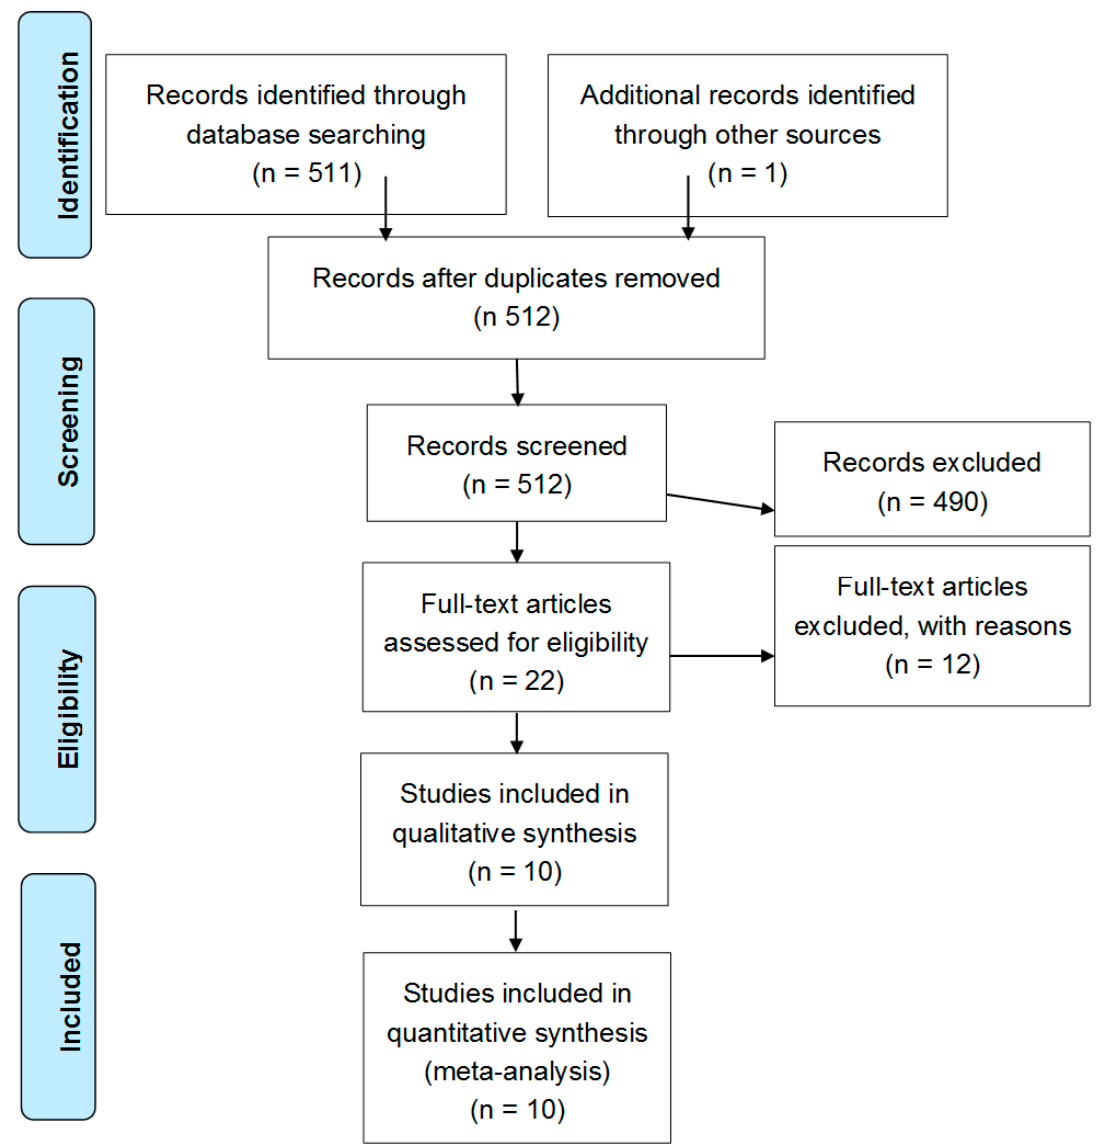
Figure 1. Preferred reporting items for systematic reviews and meta-analyses (PRISMA) flow diagram of literature search process and result.